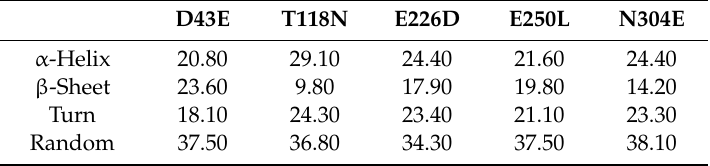
Figure 5. Circular dichroism (CD) spectra analysis of mutants. Table 3. Estimated secondary structure composition (%) of mutated HT1 lipases.